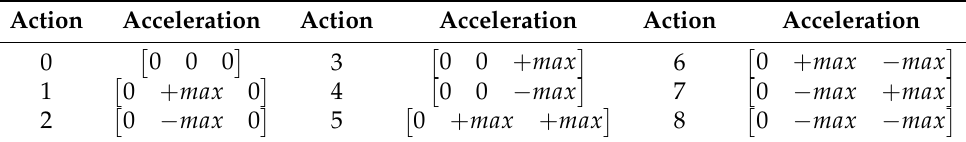
Table 1. Action space of the